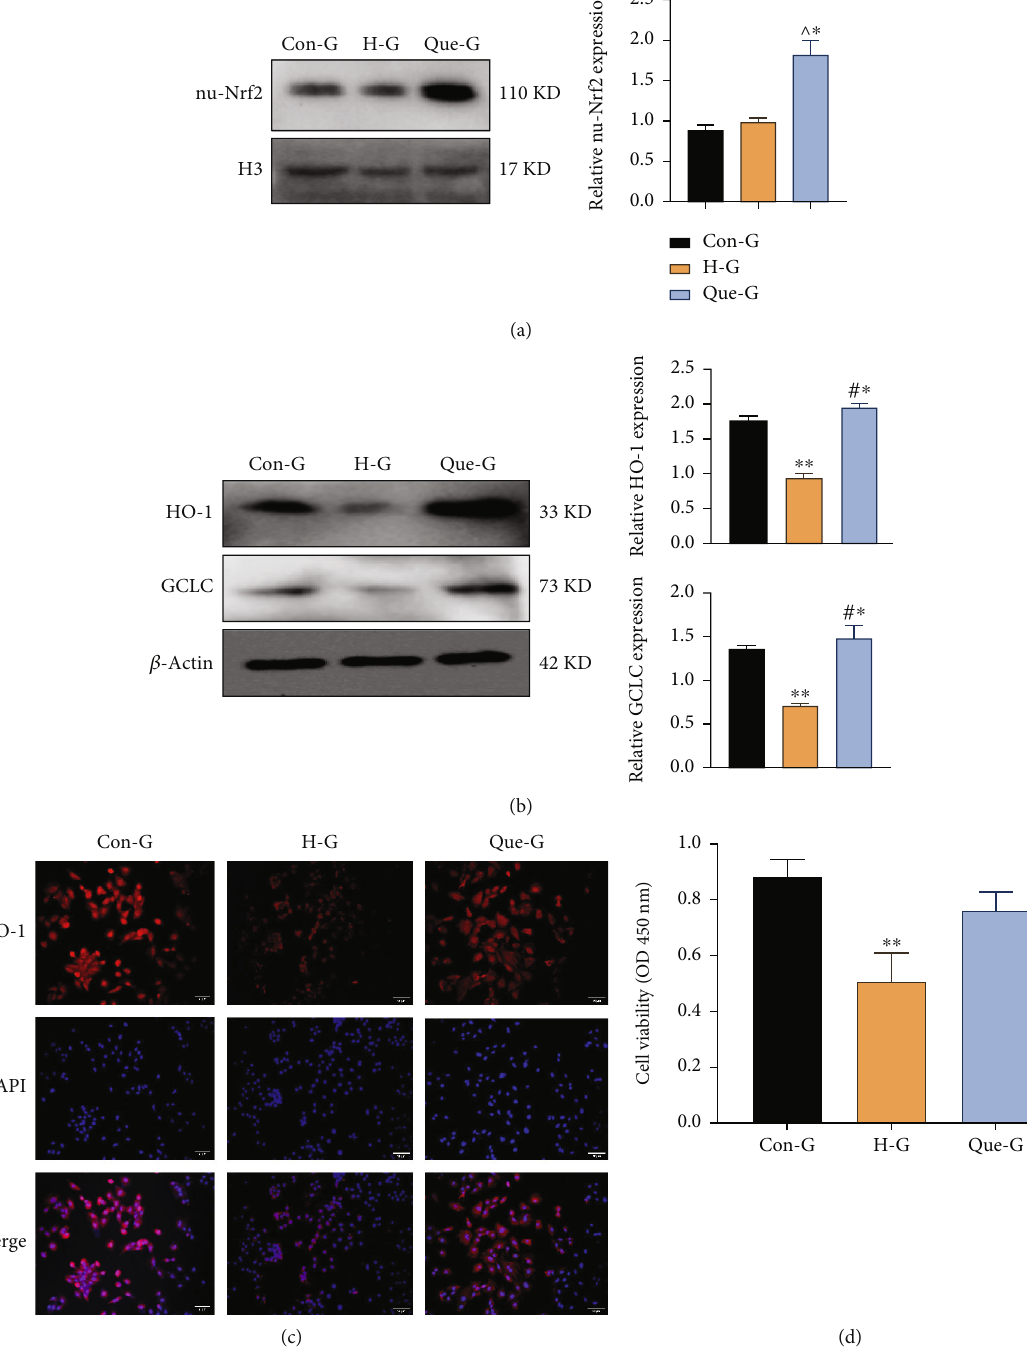
Figure 3: Quercetin promotes the nuclear translocation of Nrf2. (a) Expression levels of Nrf2 in the nucleus detected by WB. (b) Expression levels of HO-1 and GCLC detected by WB. (c) Immuno fl uorescence detection of the expression level of HO-1 in cells ( 200 × magni fi cation). (d) Viability of cells in each group detected by CCK-8 assay. H3: histone H3, used as a reference nuclear protein for normalization. CON-G: glucose concentration of 5.5mmol/L; H-G: glucose concentration of 30 mmol/L; Que-G: glucose concentration of 30mmol/L+quercetin; WB: western blotting. Data are expressed as the mean ± SD . ∗∗ P < 0 : 001 , H-G vs. Con-G and Que-G. # ∗ P < 0 : 001 , Que-G vs. Con-G. ^ ∗ P < 0 : 001 , Que-G vs. Con-G and